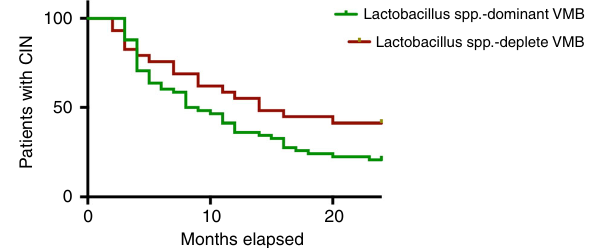
Fig. 6 Time to clearance of CIN according to baseline VMB composition at genus level. There was a trend towards slower disease regression in women with a Lactobacillus spp.-depleted VMB at baseline compared to women with a Lactobacillus spp.-dominant VMB at the time of CIN2 diagnosis ( p -value = 0.078, Log-rank test). Source data are supplied as a Source Data File. VMB vaginal